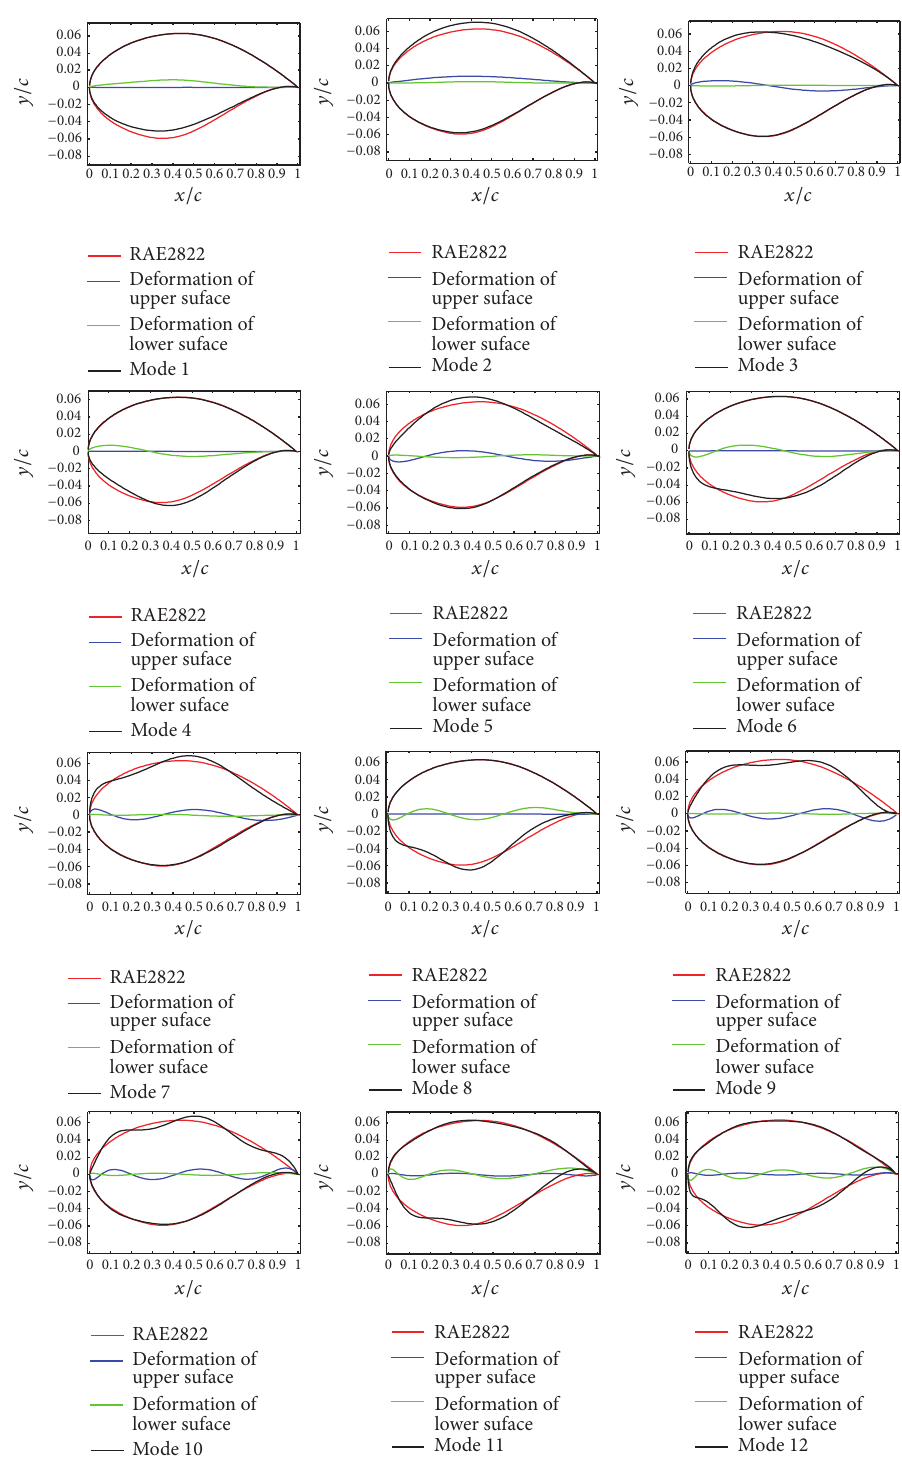
Figure 2: The first 12 deformation modes of RAE2822